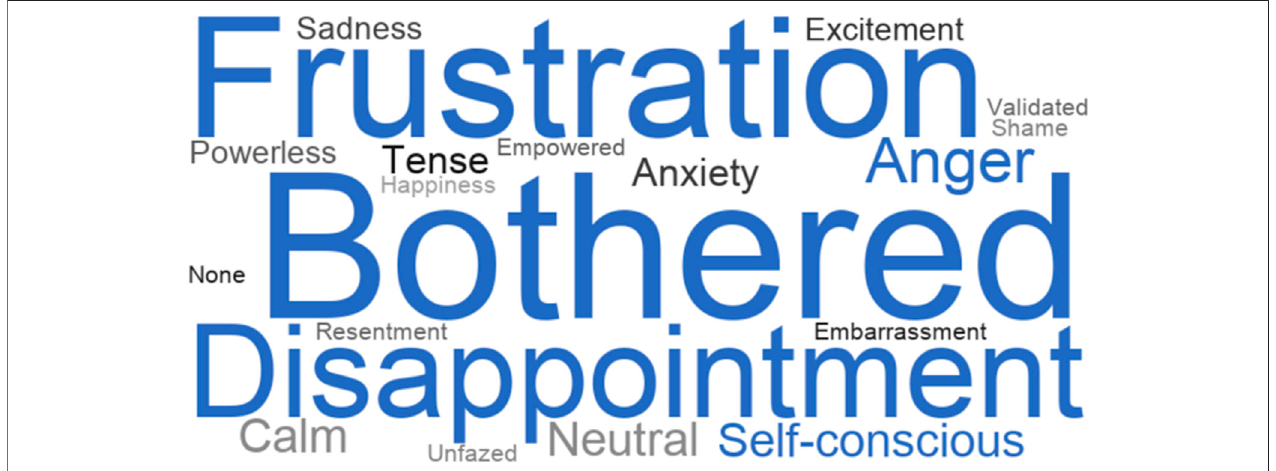
FIGURE 9 | Emotion Experienced when participants accomodated for Voice Technology Errors ( n (cid:1) 30).